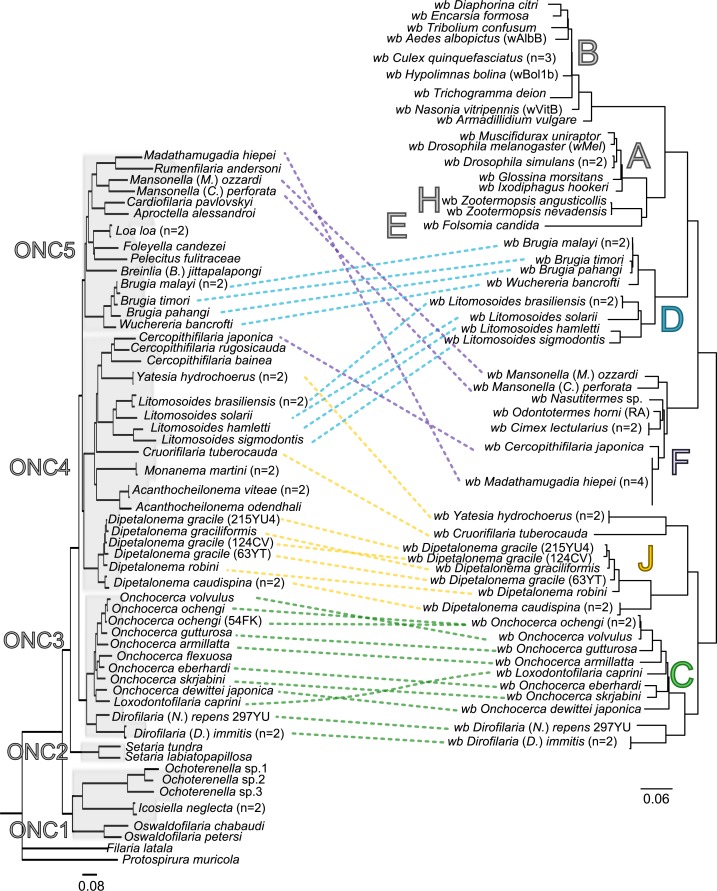
Congruence between filariae and Wolbachia phylogenies.The phylogenies of filariae and Wolbachia were performed by Maximum Likelihood (ML) inference using RAxML. The scale bar indicates the distance in substitutions per nucleotide. The filariae clades (ONC1-ONC5) were defined according to Lefoulon et al. (2015). The Wolbachia supergroups (A–H) were identified according to Werren, Zhang & Guo (1995), Bandi et al. (1998), Lo et al. (2002), and Ros et al. (2009). Abbreviation: wb, Wolbachia; n, number of studied specimens. Dotted lines show the association between a filarial species and its symbiont. Colors illustrate the bacterial supergroup in filariae.